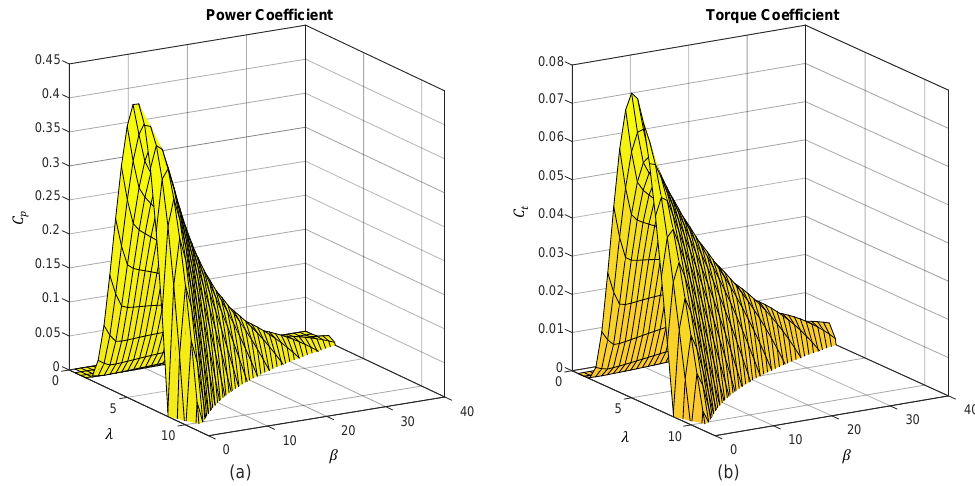
Figure 19. Coefficient proposed by Ahmed, Karim, and Ahmad [52], with variations of λ and β ; ( a ) power coefficient, ( b ) torque coefficient.